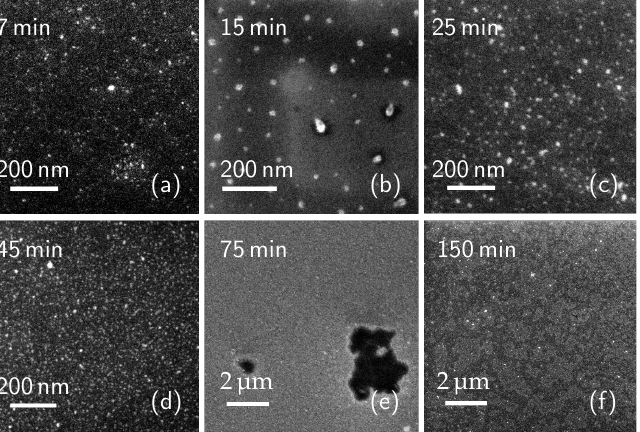
Figure 1. SEM plan images of the as-deposited samples with a deposition time of 7 ( a ), 15 ( b ), 25 ( c ), 45 ( d ), 75 ( e ), 150 ( f ) minutes. Image ( e ) shows the molecular layer next to completion, while image ( f ) exhibits the presence of molecular